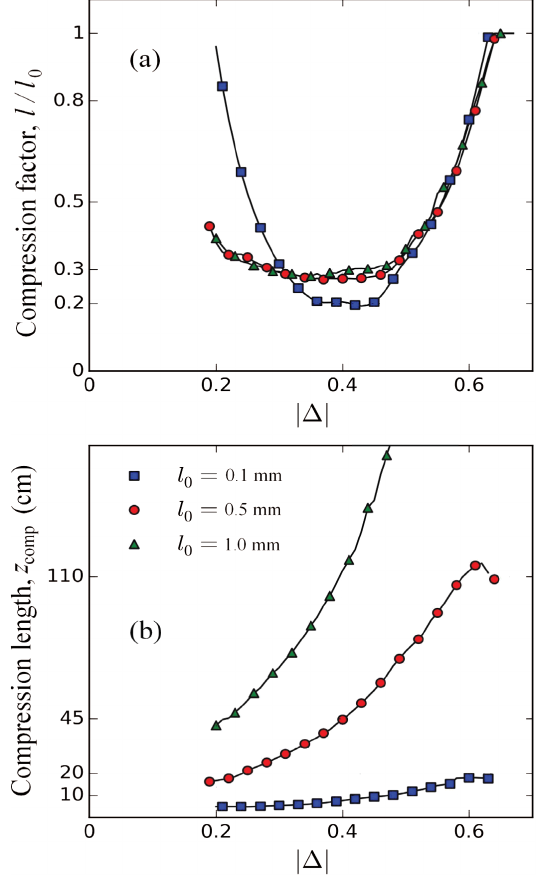
FIG. 7. Minimal compression factors l=l 0 (a) and lengths of the compressing undulator (b) versus the normalized difference between undulator and cyclotron frequencies, Δ , for electron bunches with initial lengths, l 0 ¼ 0 . 01 , 0.5 and 1